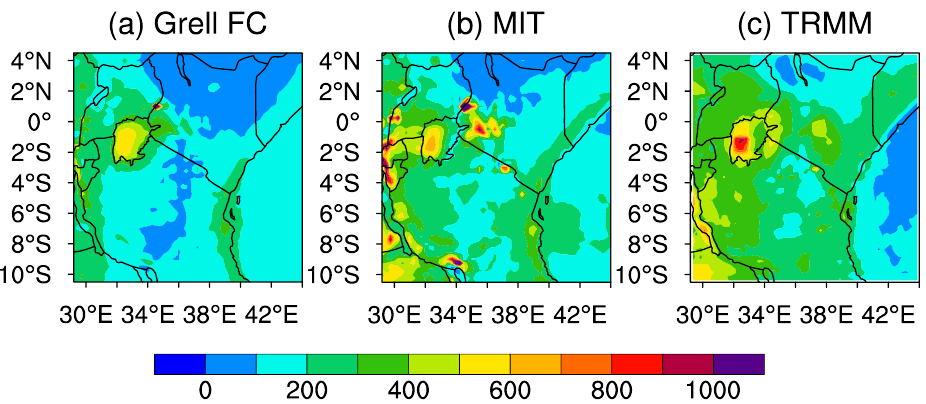
Figure 6. Total seasonal precipitation climatology over East Africa during the Short Rains from 1998–2013 for ( a ) Grell FC, ( b ) MIT-Emanuel, and ( c )